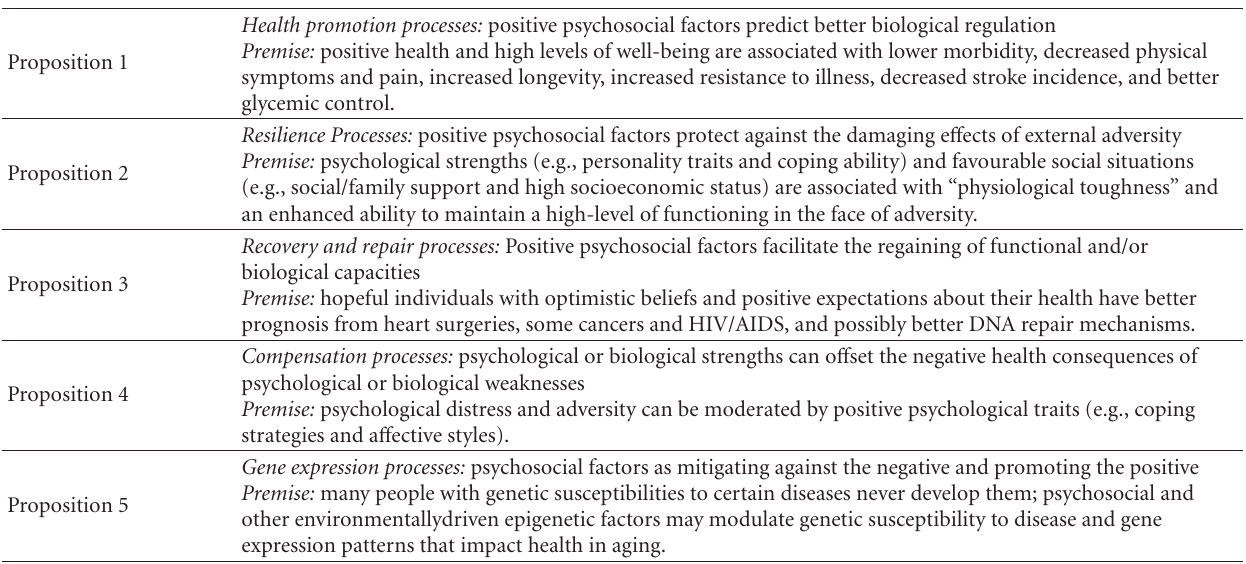
Table 1: Research propositions to advance knowledge of healthy aging—Adapted from Ry ff and Singer